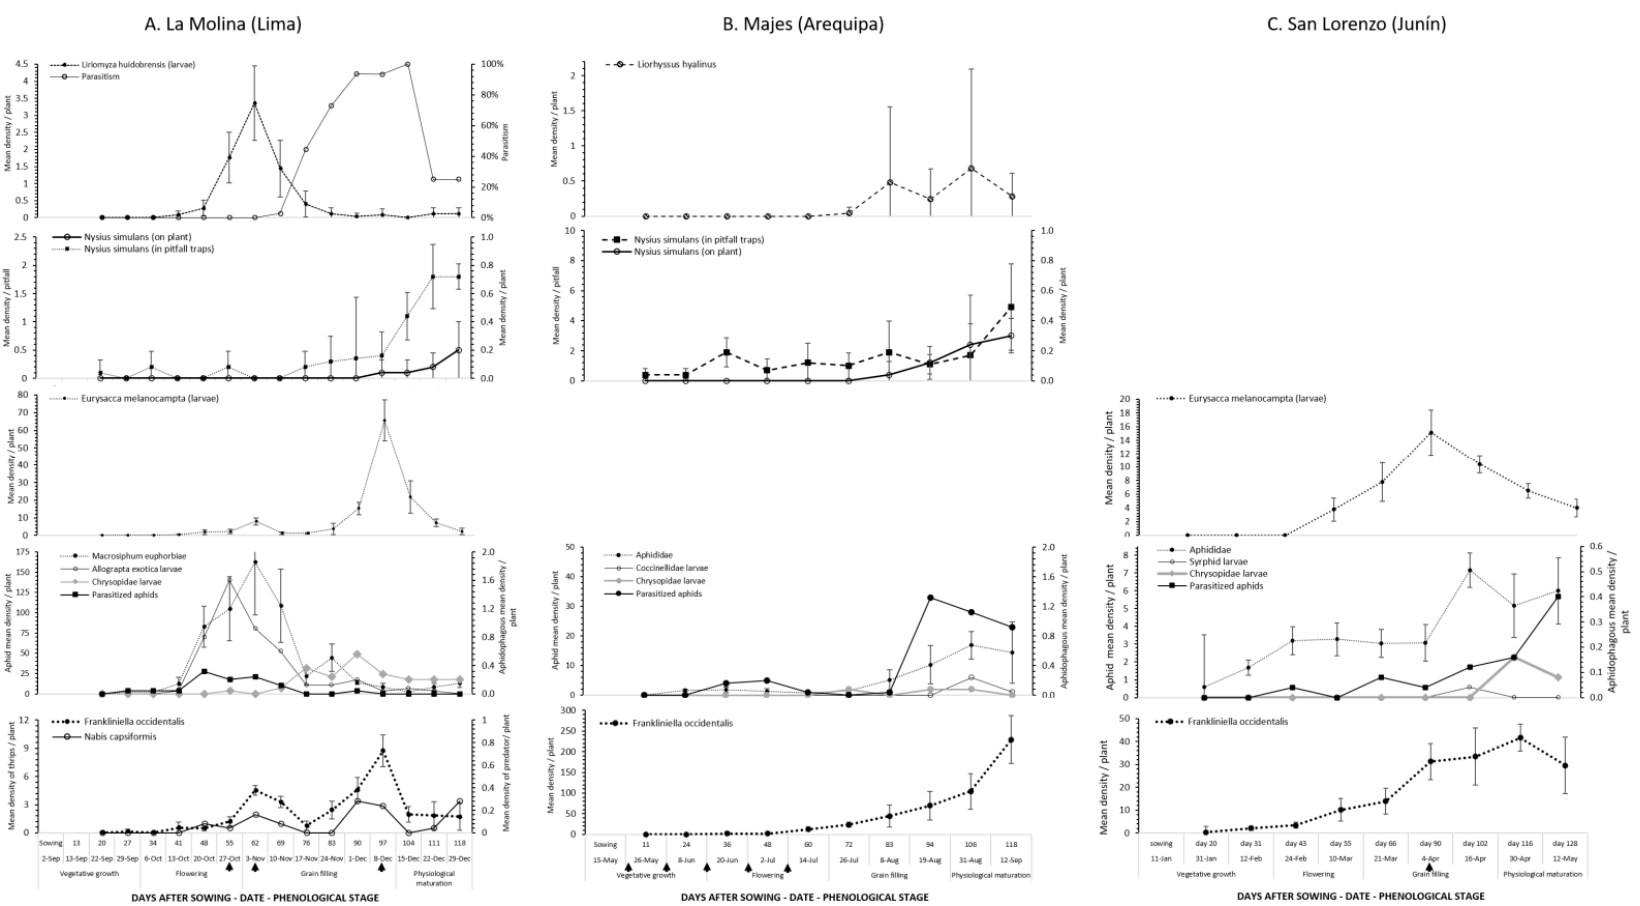
Figure 3. Seasonal incidence of the main insect pests (mean number per plant or pitfall trap ± SD) and their associated natural enemies (mean number per plant or percent parasitism) sampled on quinoa at the field sites in ( A ) La Molina, Lima (from 22/09/2015 to 29/12/2015); ( B ) Majes, Arequipa (from 15/05/2016 to 12/09/2016); and ( C ) San Lorenzo, Junín (from 31/01/2016 to 12/05/2016). Arrows on the time axis indicate the timing of the insecticide applications.